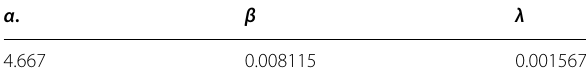
Table 1 Parameter fitting results α .